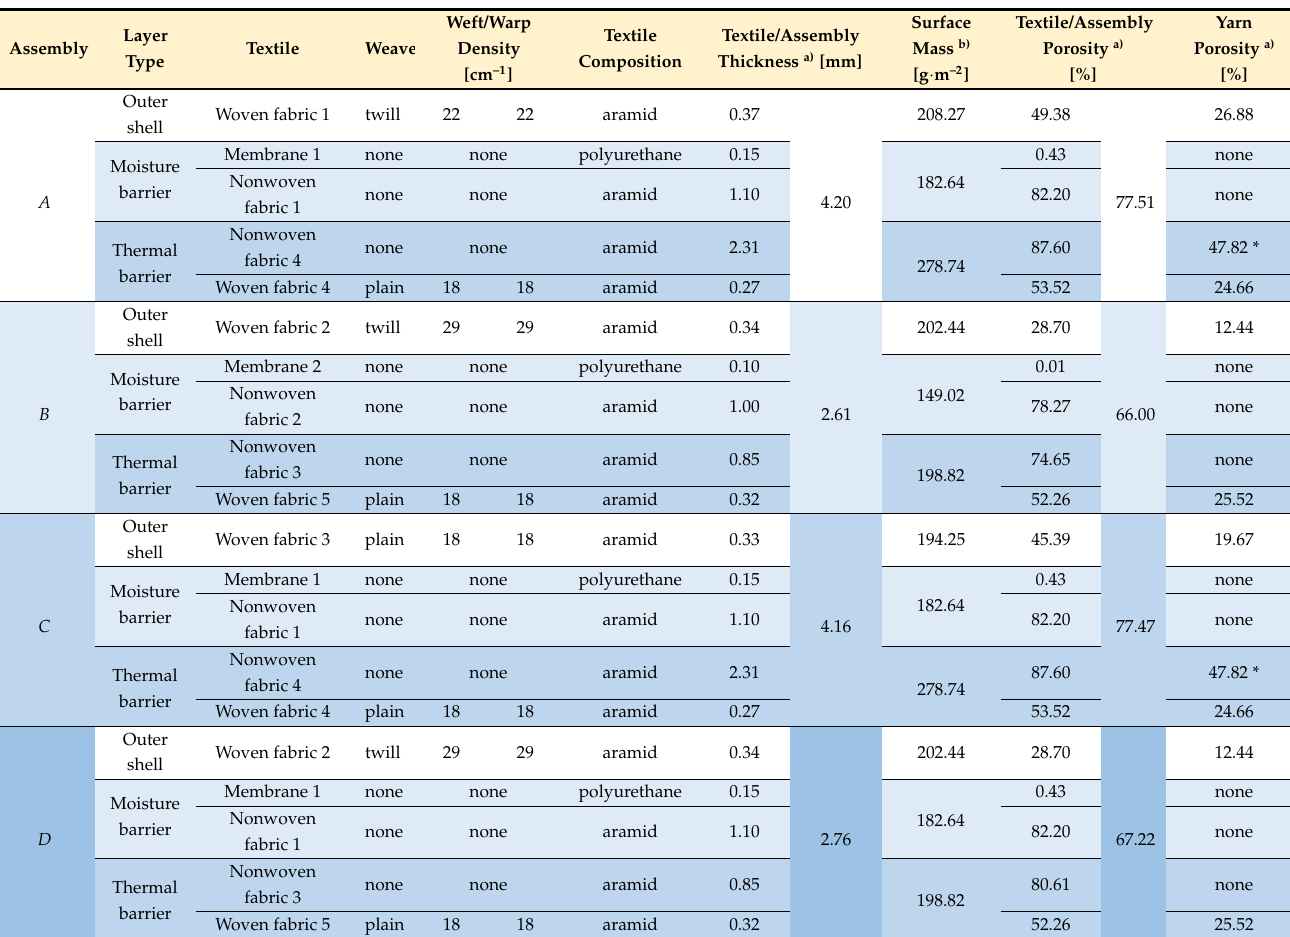
Table 1. Characteristics of four tested